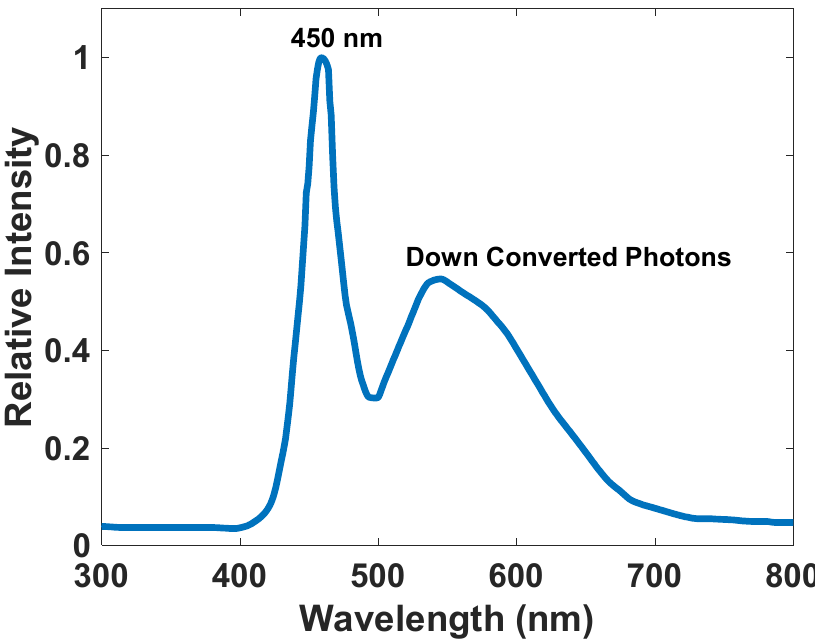
Figure 1. The emission spectrum of a commercially available white light LED. Adapted from Ref [36].